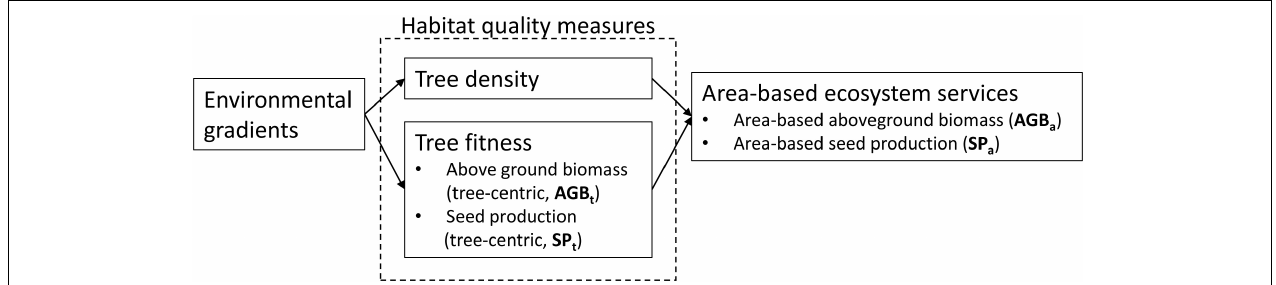
FIGURE 1 | Conceptual representation of the relation between environmental gradients, habitat quality measures, and area-based ecosystem services.